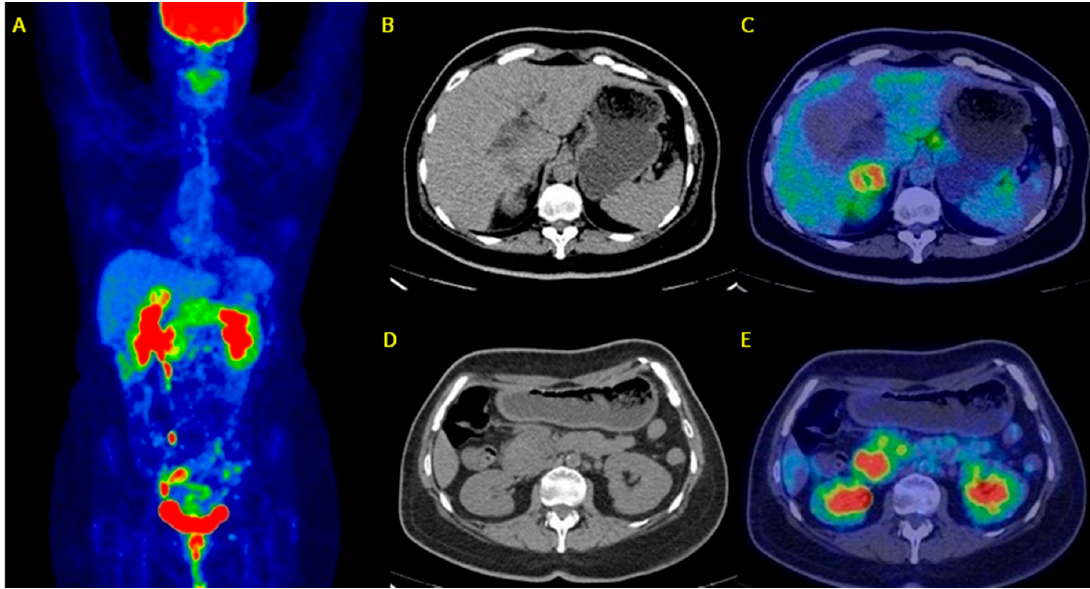
Figure 3. A sixty-two-year-old patient underwent 18 F-FDG PET/CT for metabolic characterization of a pancreatic lesion. Whole Body FDG PET/CT ( A : maximum intensity projection) revealed a focal uptake (SUVmax = 18) on the head of the pancreas ( D , E ) with a possible infiltration of the duodenum and a liver metastasis of S5 with a SUVmax = 12 ( B , C ). Histological samples of both uptakes confirmed the diagnosis of ductal adenocarcinoma infiltrating duodenum and liver metastasis. (Images from Nuclear Medicine Unit, Fondazione Istituto G.Giglio of Cefalù, Italy). Legend: A = Maximum intensity Projection (MIP); B-D = Axial images of low-dose CT; C-E = PET/CT fused images